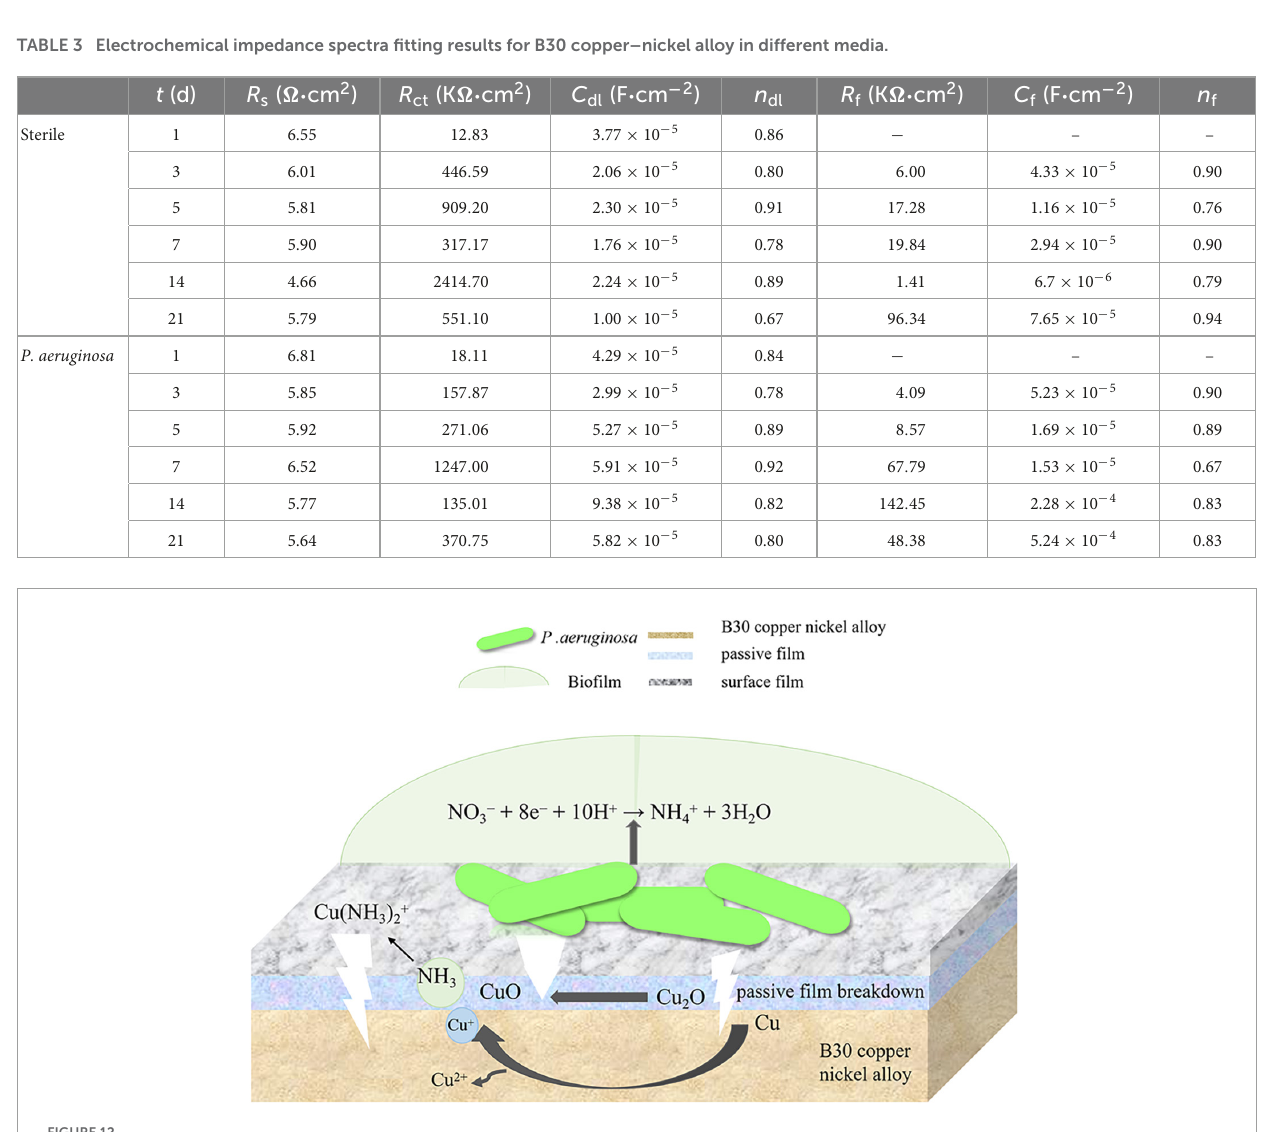
FIGURE12 Acceleration mechanism of P. aeruginosa on the B30 copper–nickel alloy pitting corrosion.